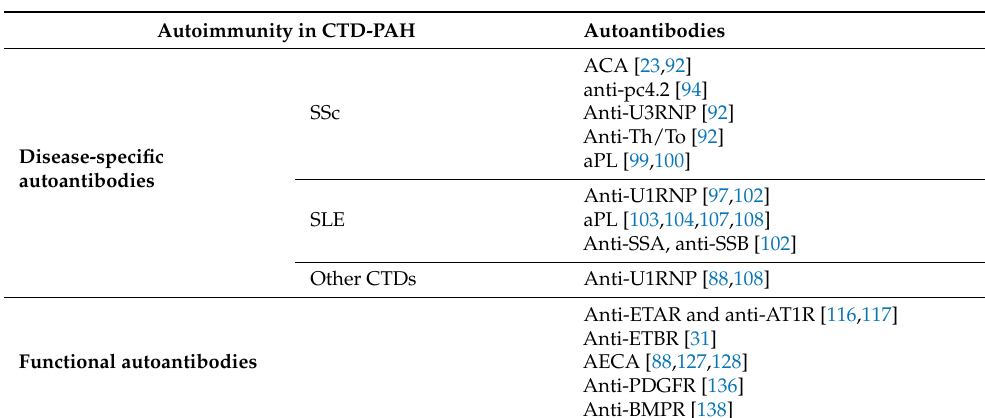
Table 2. Autoantibodies in